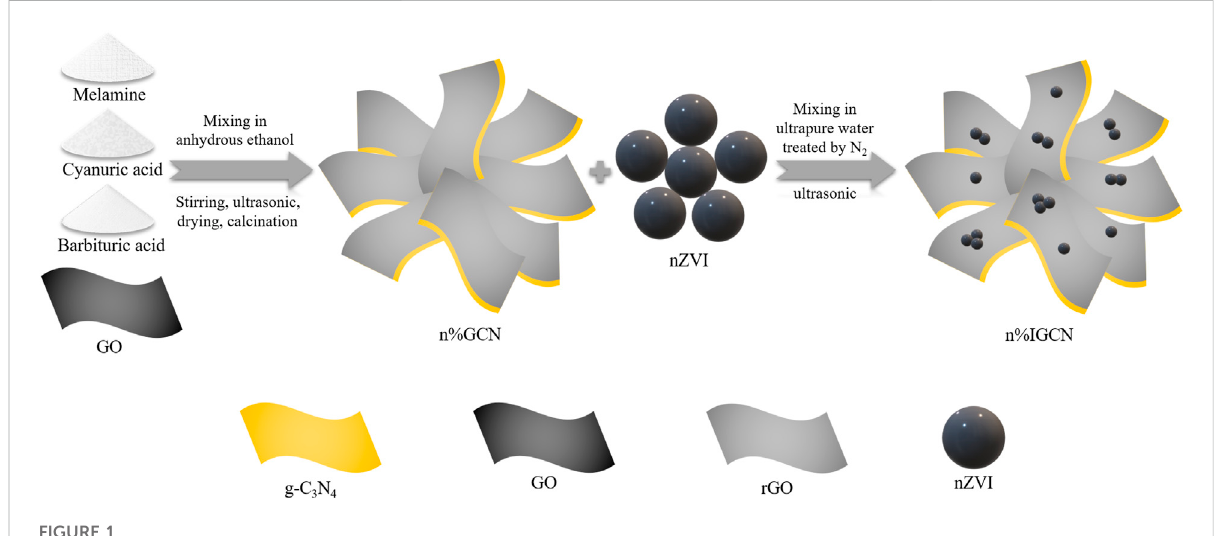
FIGURE 1 Schematic of synthesis procedures for n% IGCN